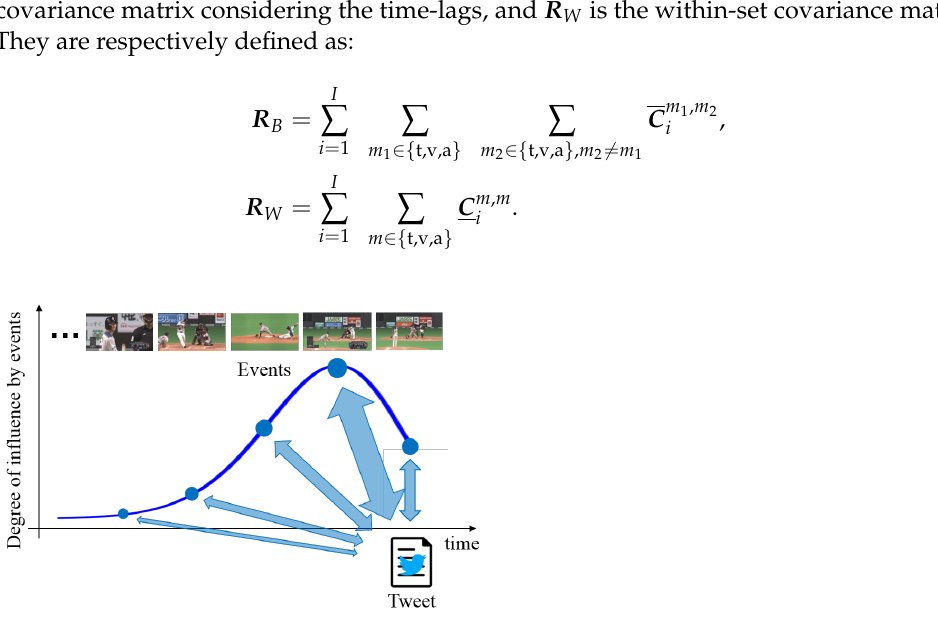
Figure 2. The relationship between a tweet and its corresponding multiple previous events. The tweet corresponds to events from the present to the past. Furthermore, these events are weighted by using the degree of influence defined on the basis of the Poisson